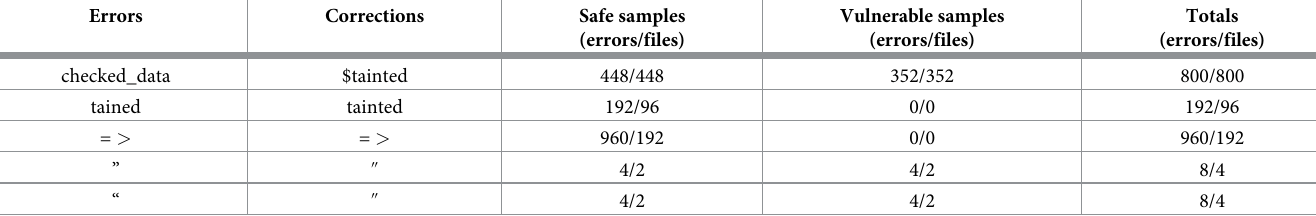
Table 3. Errors found by manul